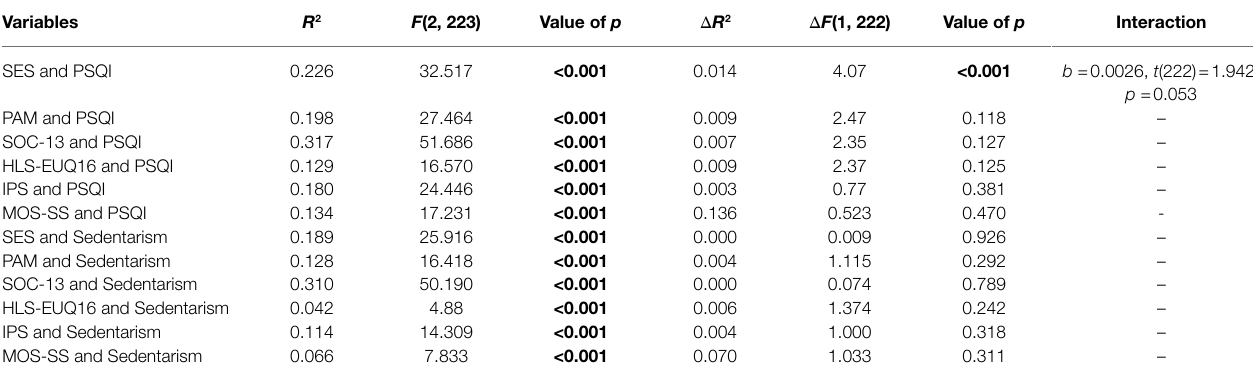
TABLE 3 | Linear regression analysis of personal factors, lifestyle variables, and the interaction between them on depression. Variables R 2 F (2,